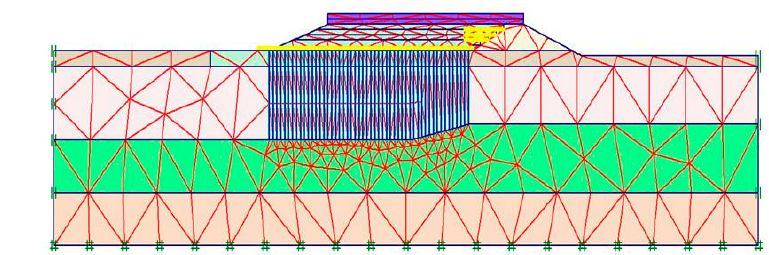
Figure 8. Drainage line model.